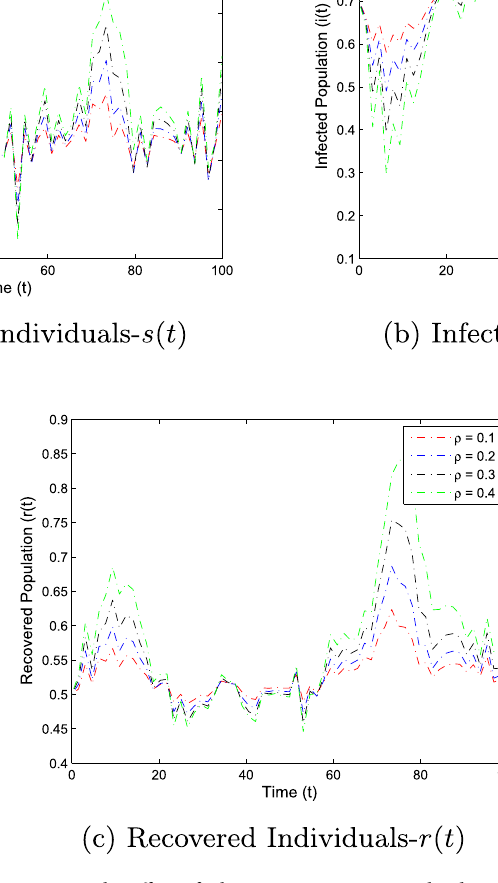
Figure 9. The graphs represent the effect of white noise intensity on the dynamics of the compartmental population of the epidemic problem (1) in case of disease persistence